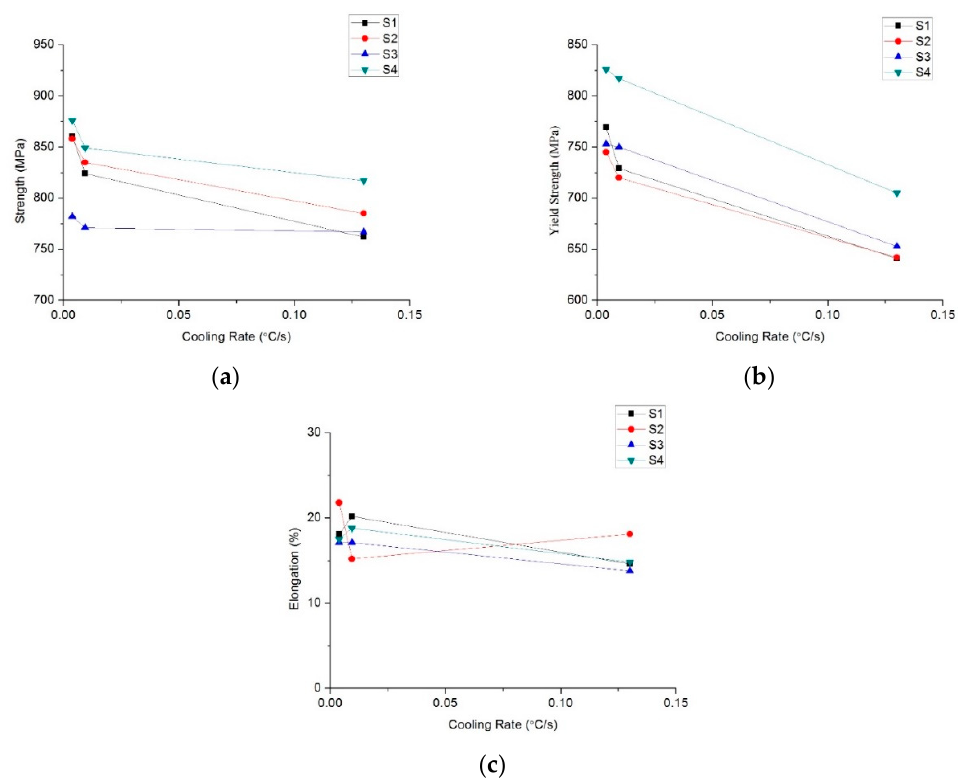
Figure 9. Mechanical properties of the tested steels at the different cooling rates: ( a ) tensile strength; ( b ) yield strength; ( c ) elongation after fracture.